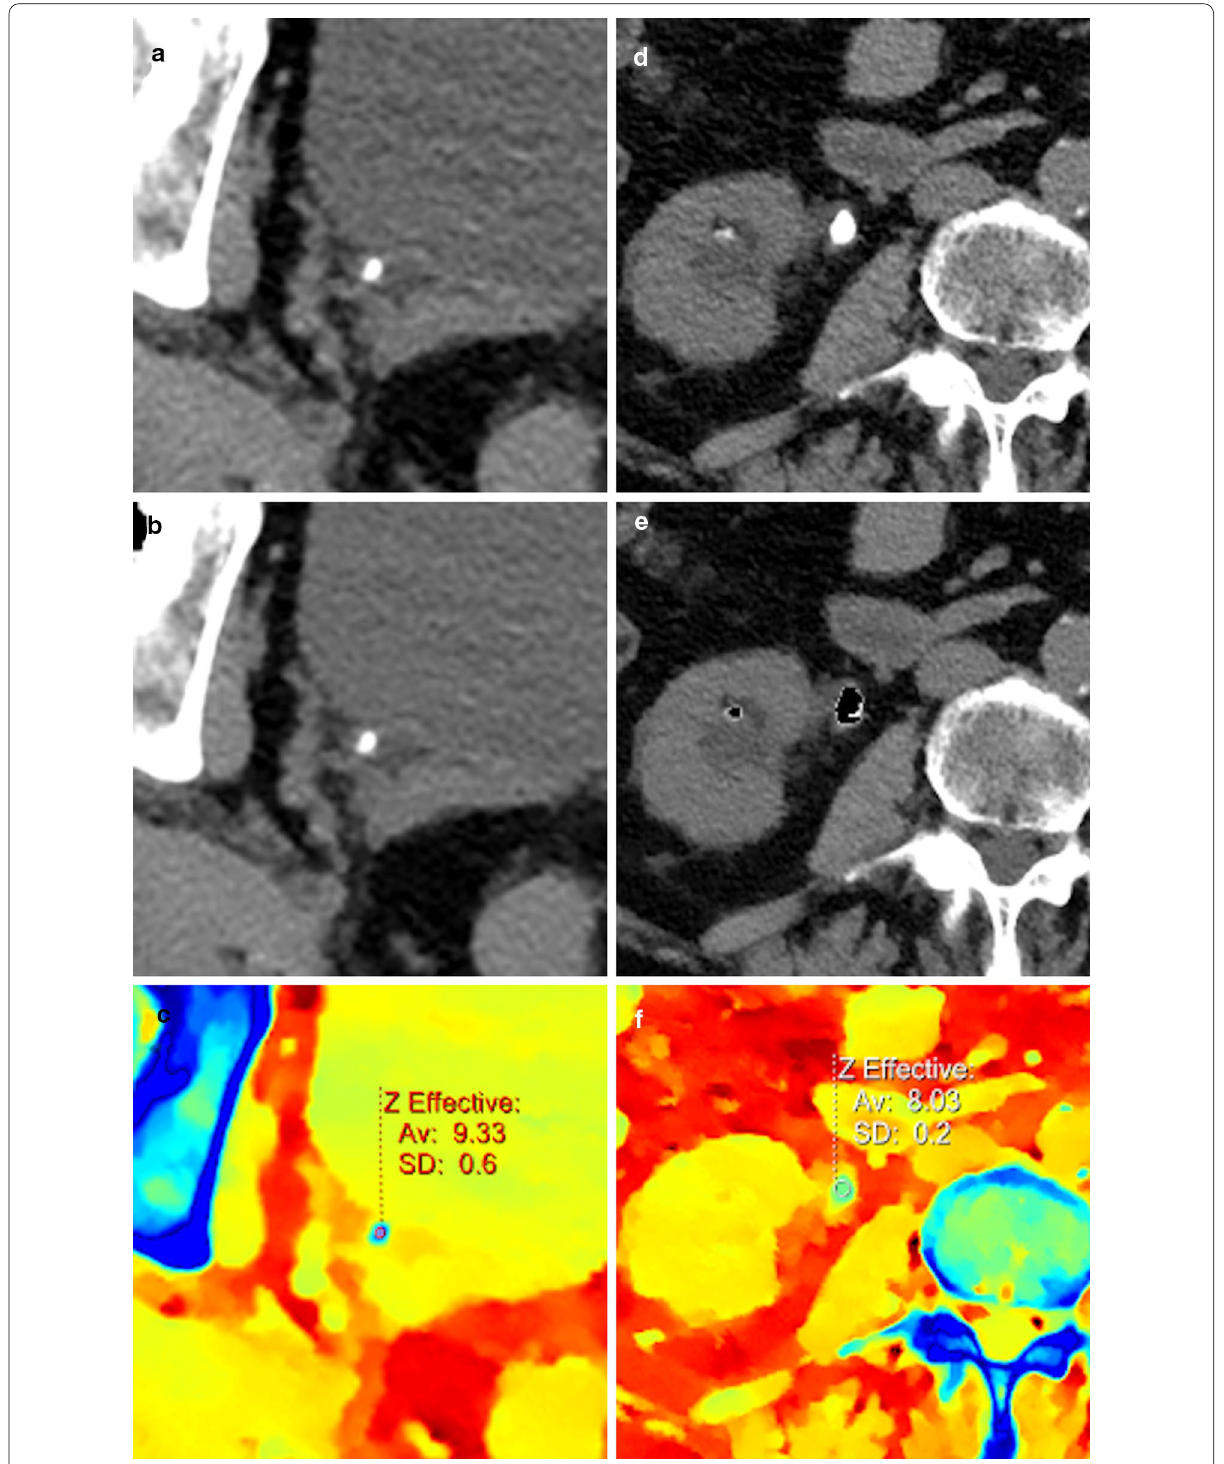
Fig. 9 Side-by-side images showing uric acid evaluation in two different patients evaluated for nephrolithiasis. a – c showing a calcium-containing stone in the distal ureter, ( d – f ) showing uric acid stones in the lower pole calix and proximal ureter, proven as uric acid stones by laboratory evaluation following lithotripsy and stenting. a , d conventional anatomic images, ( b , e ) "uric acid removed" overlay images, on which uric acid is removed from the image leaving a black pixels, and ( c , f ) are atomic number images showing the different atomic numbers of the different types of